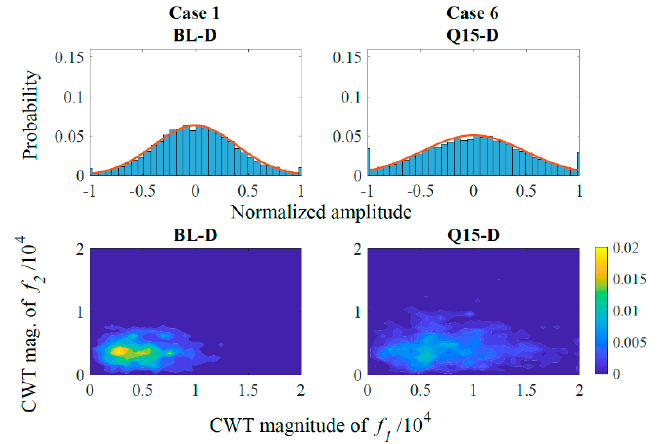
Figure 7. Histogram of the pressure signal ( top ) and joint histogram of CWT coefficients of f 1 and f 2 ( bottom ) of Cases 1 and 6.